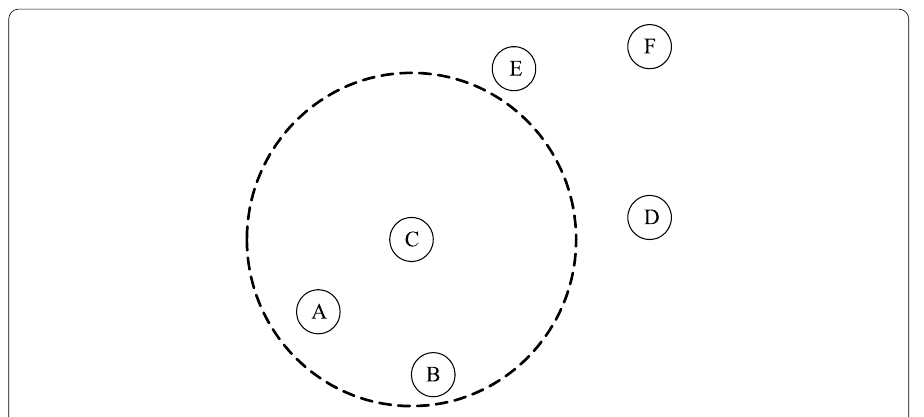
Fig. 1 Connectivity of the node